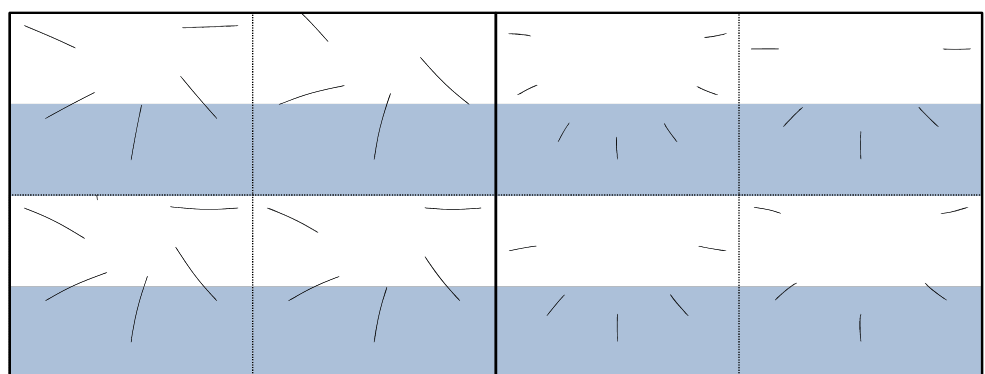
Figure 6. Geometries of water wheels from the broader Pareto front of the optimisation. Shown on the left are four geometries from group P1; on the right, four geometries are depicted from P2 group. In this figure, blade thickness is slightly exaggerated for a clearer